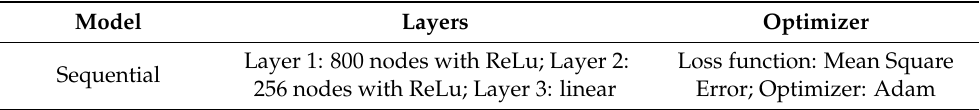
Table 1. Dense deep learning model for multi-input multi-output regression (DR). Model Layers Optimizer Layer 1: 800 nodes with ReLu; Layer 2: Loss function: Mean Sequential 256 nodes with ReLu; Layer 3: linear